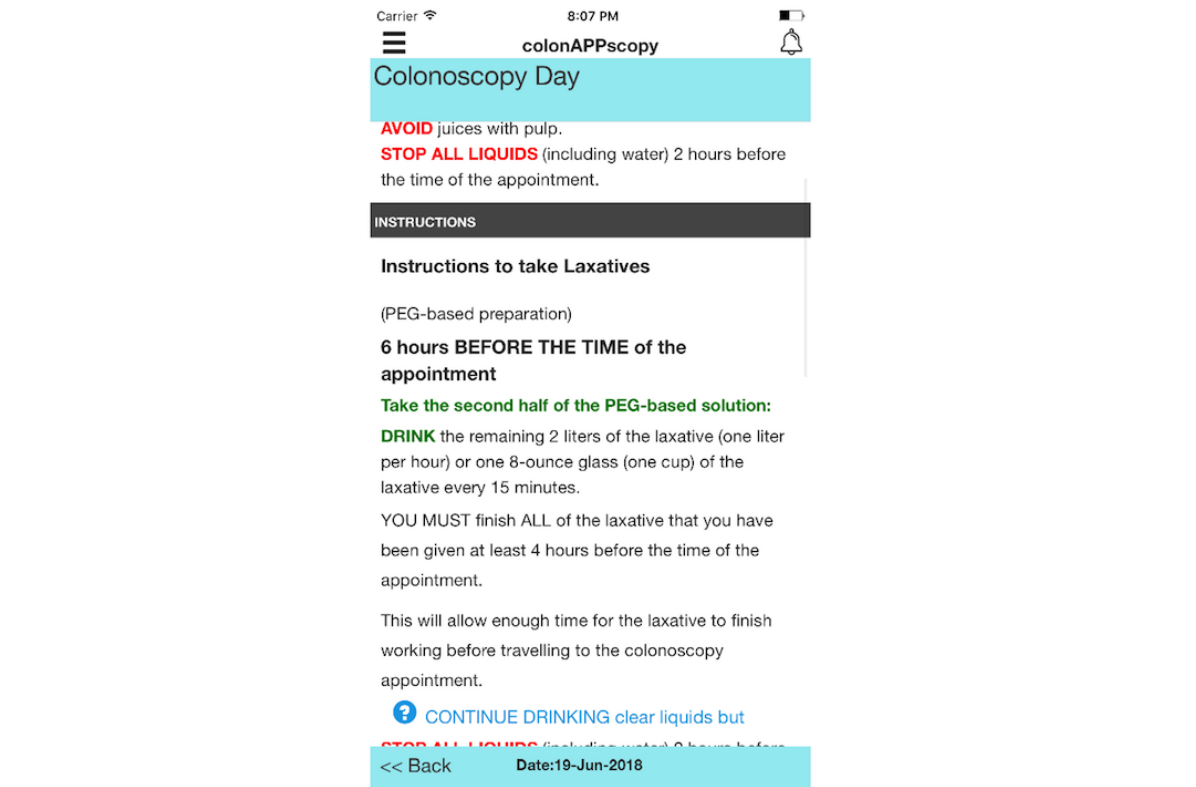
Figure 2. Screenshot of the colonoscopy day in